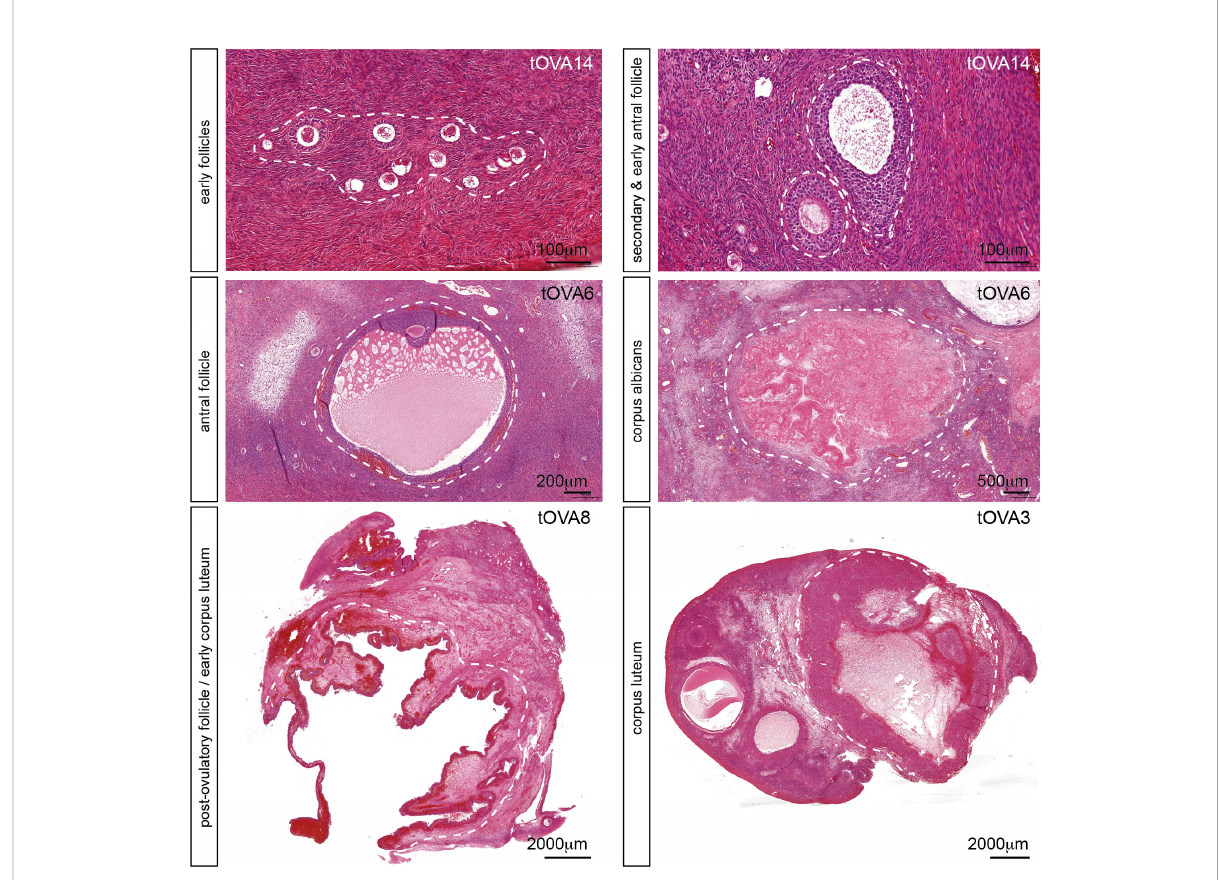
FIGURE 1 Folliculogenesis in transmasculine ovaries. Hematoxilin-eosin staining on ovarian histological sections from several transmasculine donors showing different follicular stages, such as early follicles (primordial, transitional, primary and early secondary), secondary and early antral follicles, antral follicles, post-ovulatory follicles (or early corpus lutea), corpus lutea and corpus albicans. Scale bars are